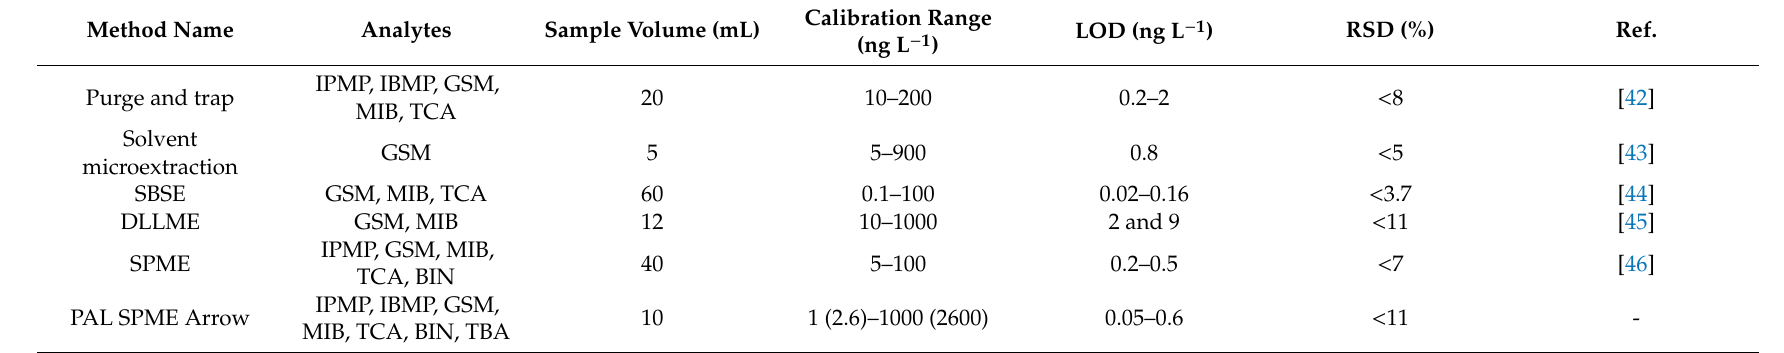
Table 4. Comparison of the developed PAL SPME Arrow with similar methods for determination of taste and odor compounds in water samples. Table reprinted with permission of Springer from Reference [18],